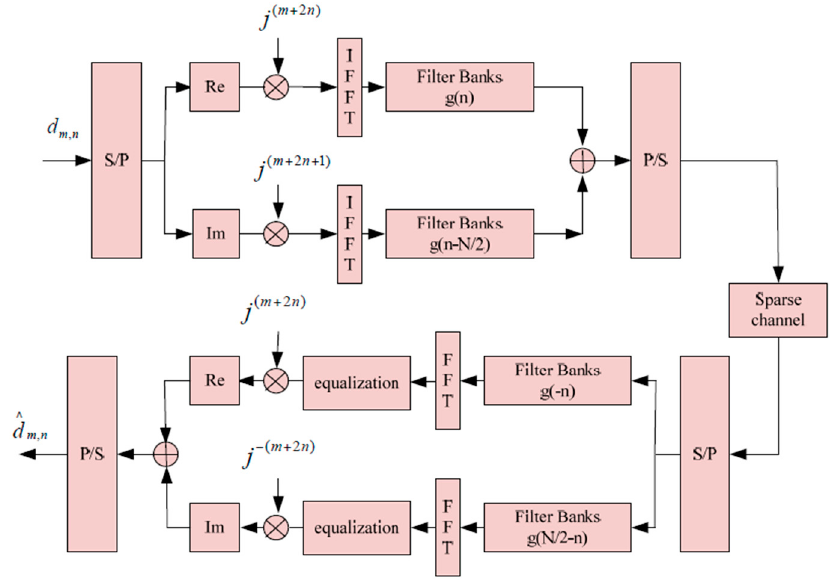
Figure 1. Implementation diagram of the FBMC/OQAM system [ 35 ].